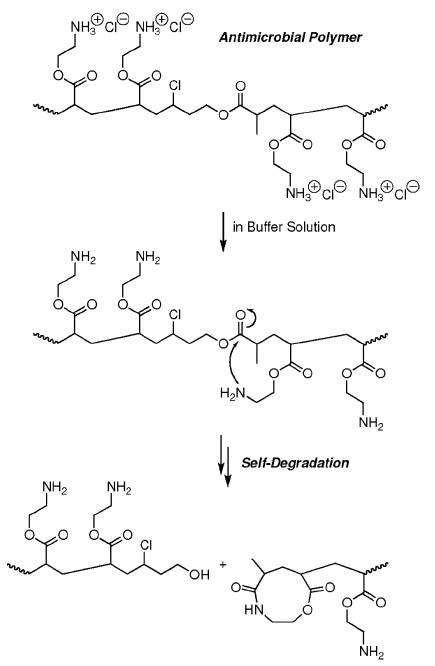
Figure 8. Polymers with degradable units synthesized by concurrent ATRP and ATRA step-growth polymerization. Adapted with permission from [63], Copyright© 2012 American Chemical